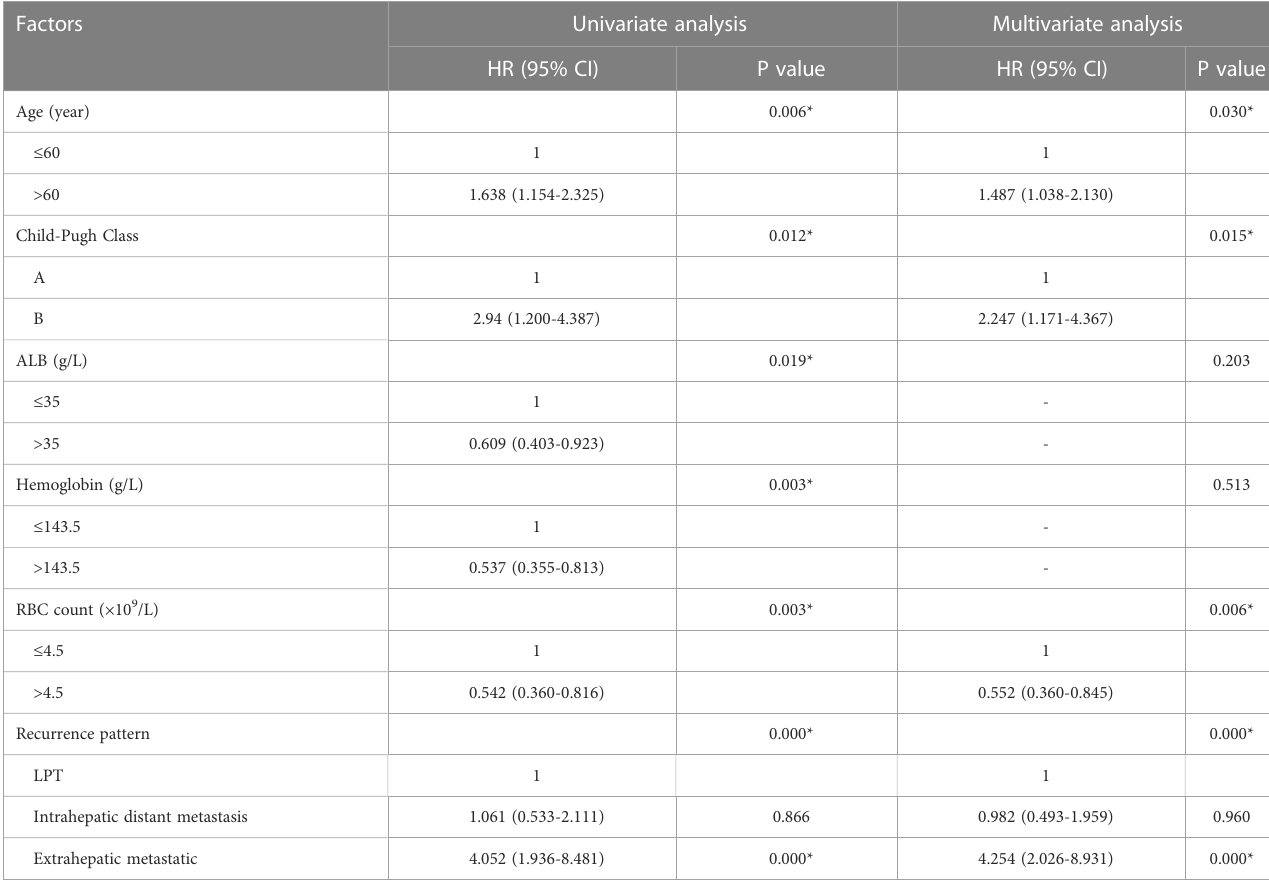
TABLE 4 Univariate and multivariate analysis of the prognostic factors for overall survival in the entire study population (N = 406).